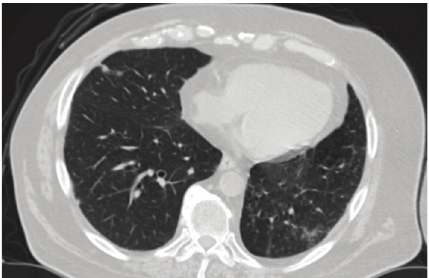
Figure 5: Computed tomography scan of the thorax showing right-sided pulmonary metastases approximately 3 weeks after radiotherapy to other targets. Marked reduction in size.